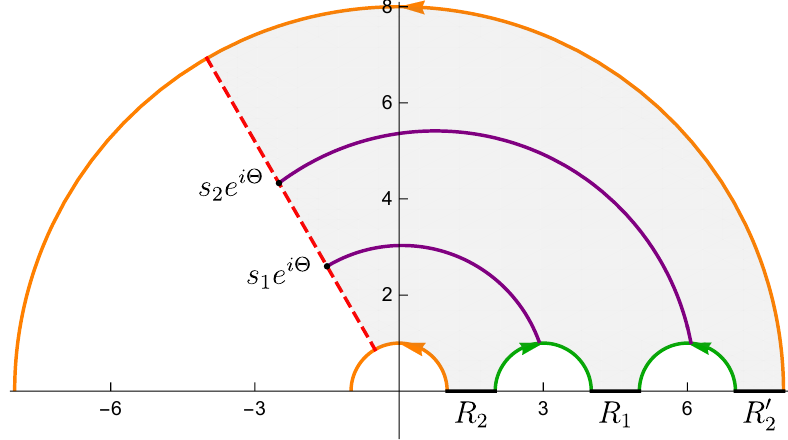
Figure 14 . An infalling geodesic (purple) with brane endpoints s 1 = 3 and s 2 = 5 (black points on dashed red segment), and circle data unchanged from (cid:12)gure 12. The larger purple arc is part of a large semicircle which is the image under (cid:13) 2 (3.11) of the smaller semicircle that includes the smaller purple arc. The two purple arcs are joined smoothly by the identi(cid:12)cation of the green semicircles. For (cid:12)xed s 1 and s 2 , the curve shown is the unique infalling geodesic which passes through the speci(cid:12)ed